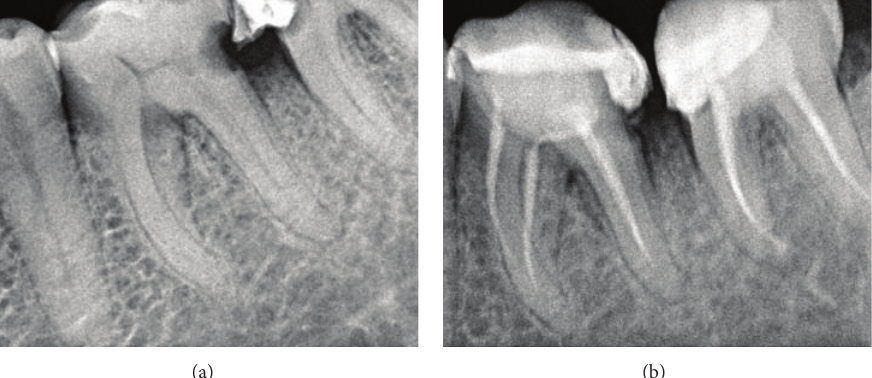
Figure 1: (a) Preoperative radiograph of the left mandibular first molar showing a deep carious lesion on the distal aspect of the crown. (b) Postoperative radiograph of the left mandibular first molar showing an incomplete and incorrect root canal filling, associated with changes of the initial curvature of the mesiobuccal